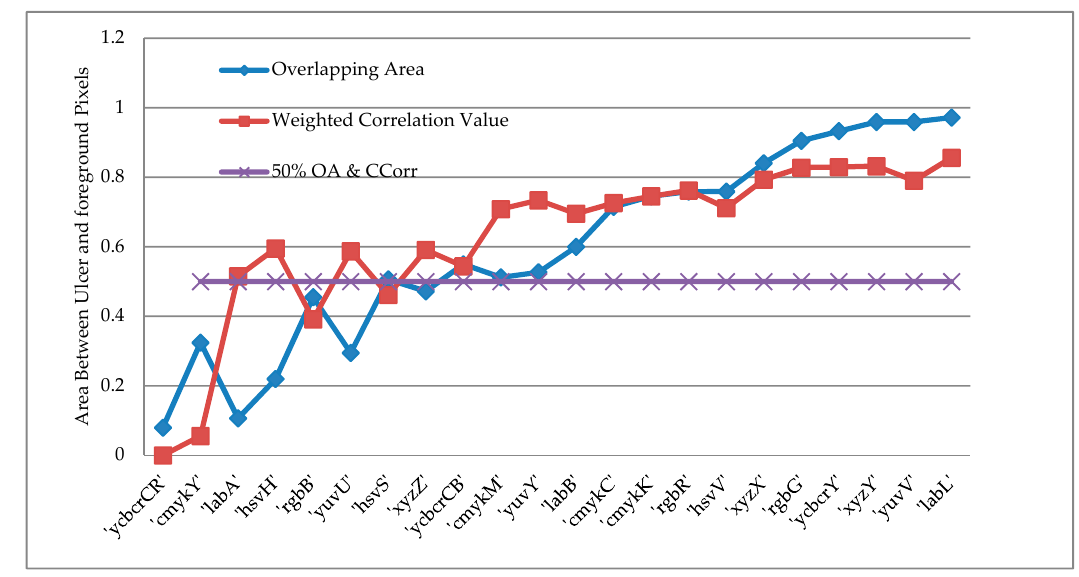
Figure 3. Comparison of overlapping area and Weighted correlation value.